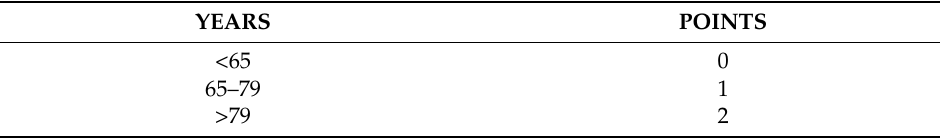
Table A3. Age. Table A4. Age.